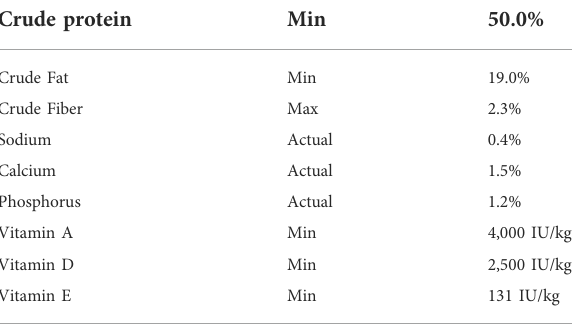
TABLE 1 Guaranteed analysis of the commercial balanced diet used. Bluewater Feed Company Trout 2M 50-19. Crude protein Min 50.0% Crude Fat Min 19.0% Crude